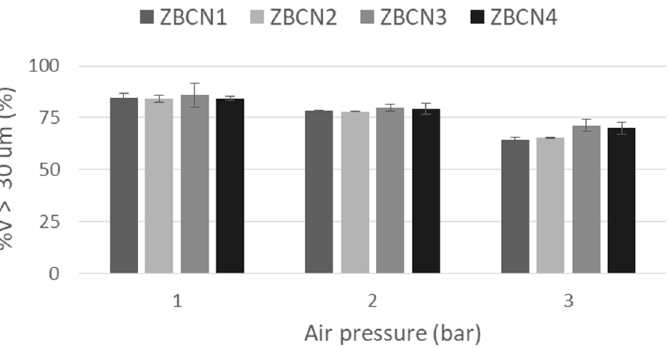
Figure 7. Dependence between the air pressure and the volumetric share of the droplets with diameters greater than 30 µm.